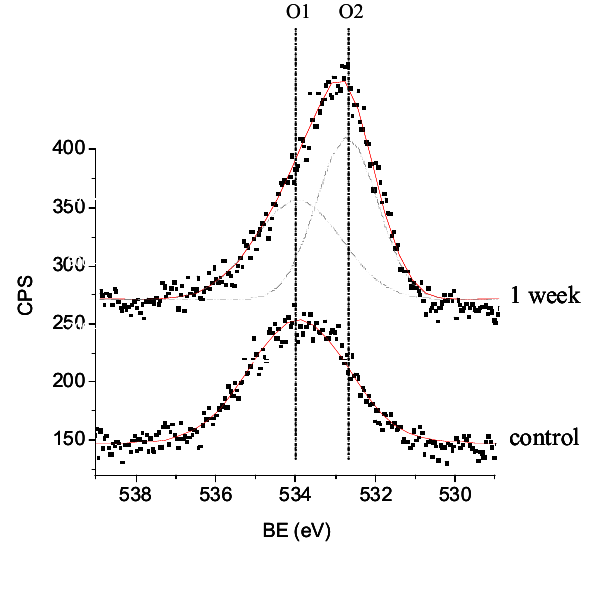
Figure 4. Representative XPS O (1s) spectra obtained from flat as-deposited and flat aged (1 week) samples, including curve